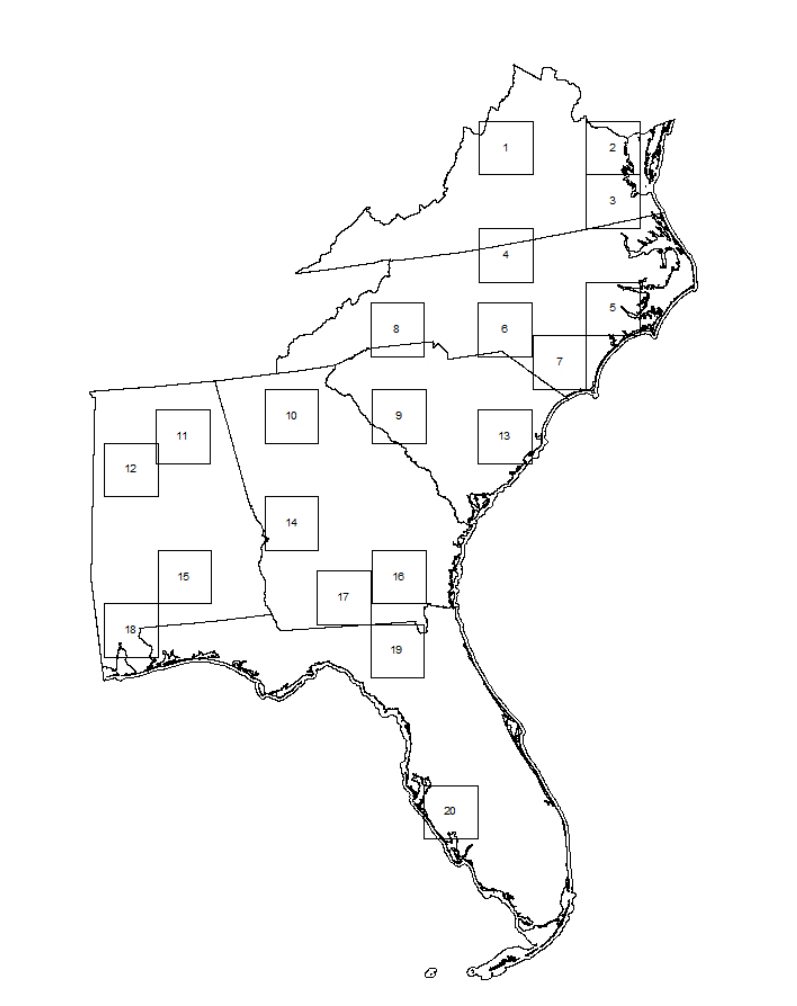
Figure 2. Locations of the 20 randomly selected subregions used for pattern accuracy